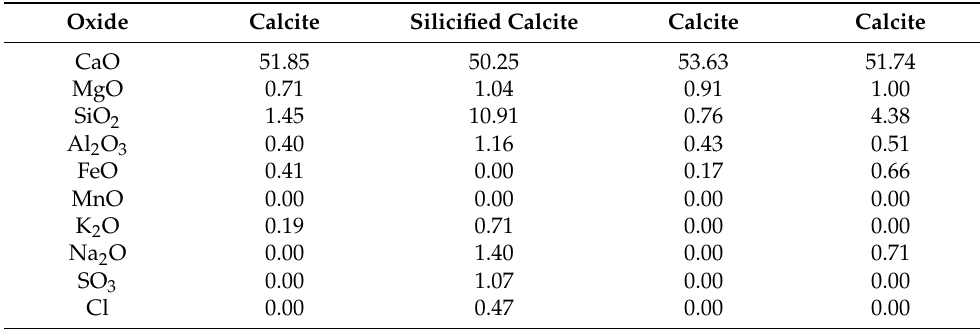
Table 1. Chemical composition of minerals (according to electron microprobe analyses) of dolomitic limestone samples taken from the borehole core, wt. %.